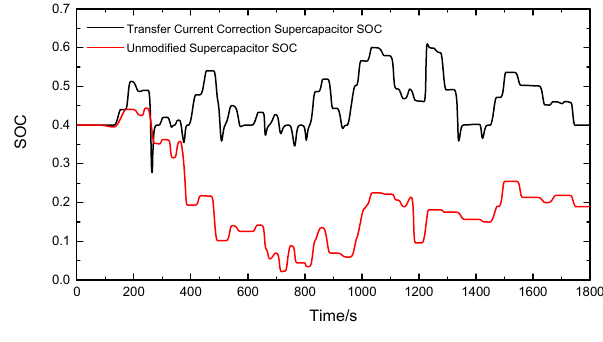
Figure 10. SOC change of supercapacitor.